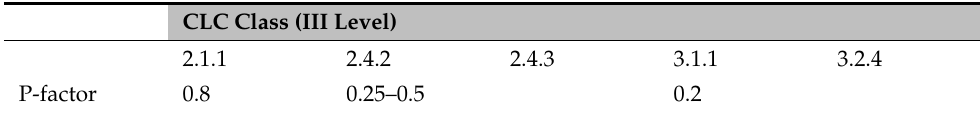
Table 2. Relationship between CORINE Land Cover Class and P factor value for different land uses following the “Bazzoffi”